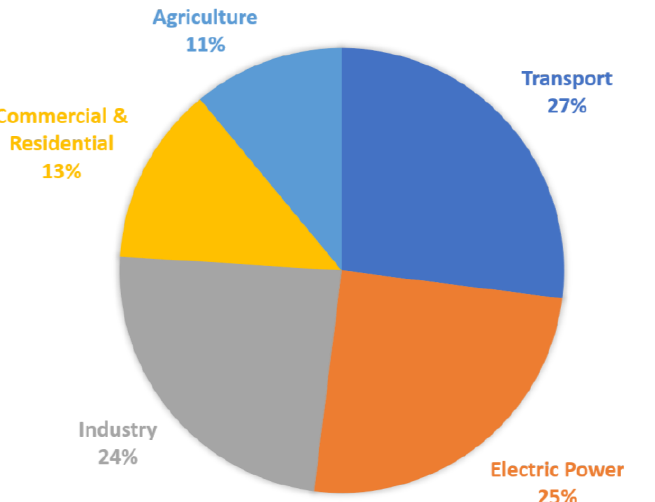
Figure 1. CO2 emissions by economic sector in the USA (source—United States Environmental Protection Agency).